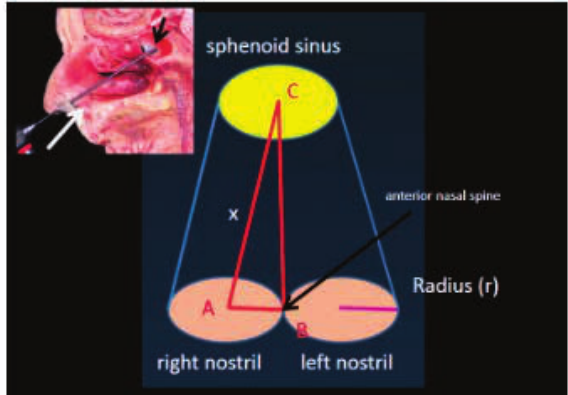
Figure 7: Image and a cylindrical diagram with reference lines rele- vant to the